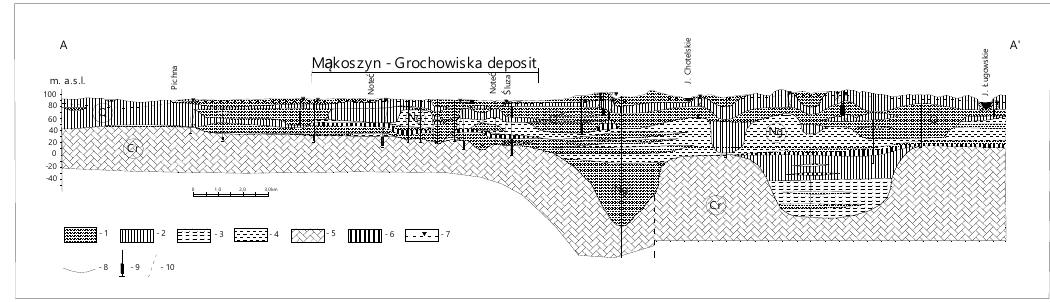
Figure 7. Groundwater flow modeling study for the proposed M ą koszyn-Grochowiska open pit in